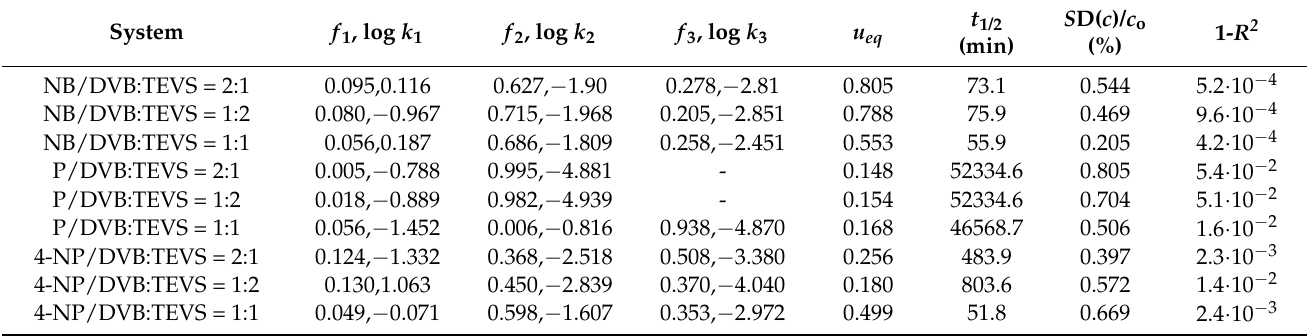
Table 4. Optimized parameters of m-exp